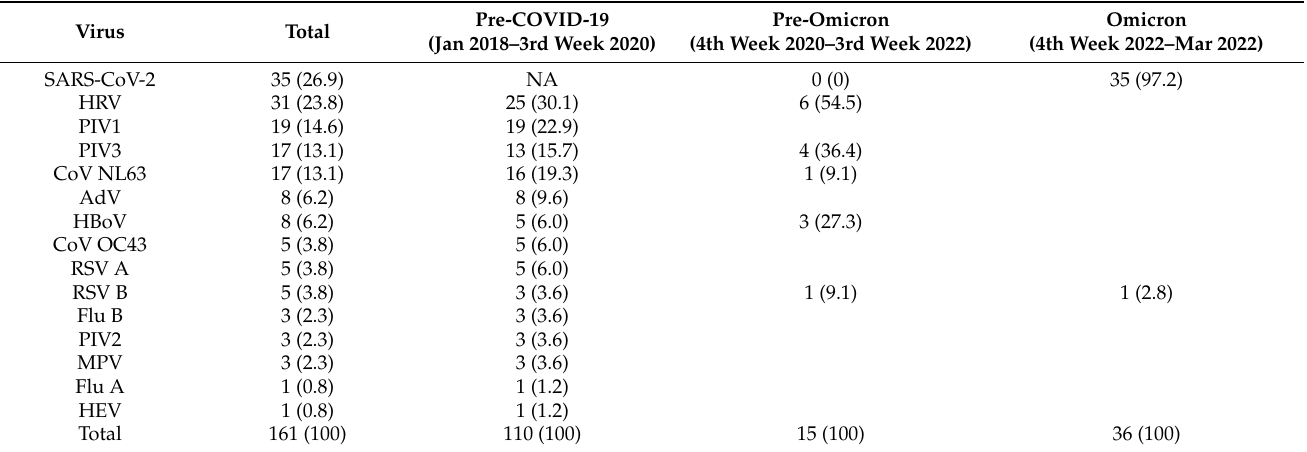
Table 2. Virologic distributions in children diagnosed with croup during 2018–2022, South Korea.